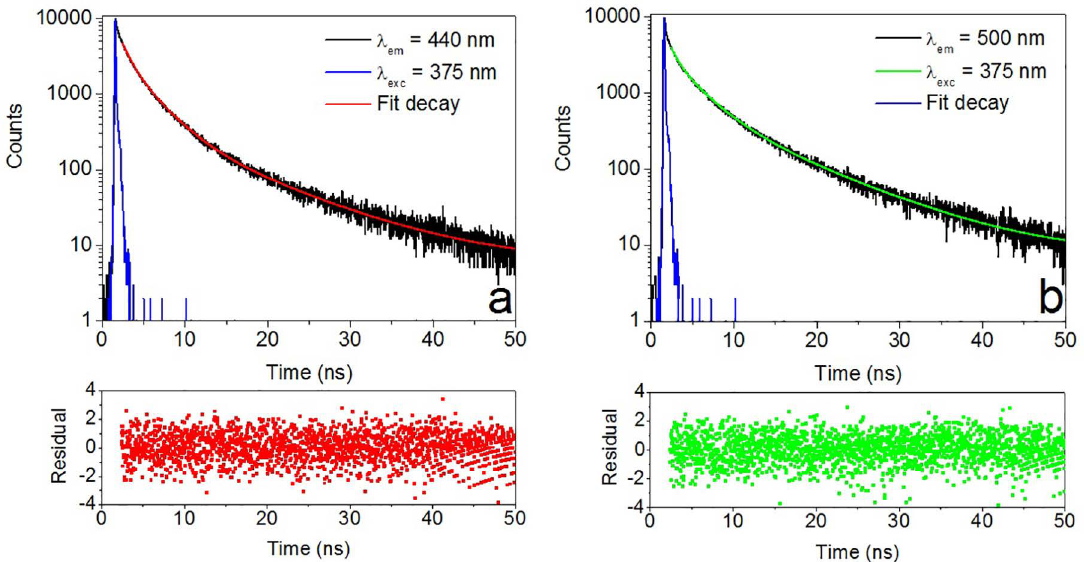
= 375 nm): a) λ = 440 nm; and b) λ exc em